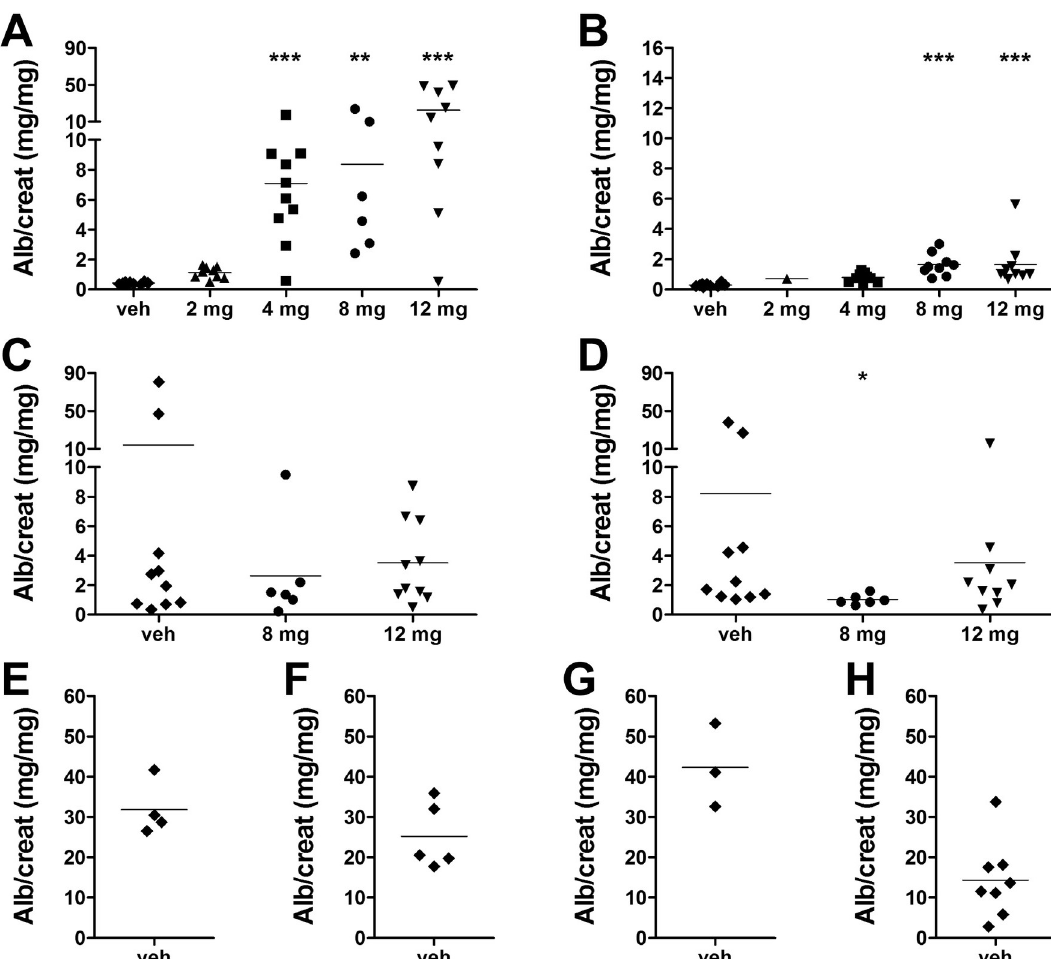
Fig 1. Different doses healthy plasma were injected in the Thy-1.1 mice with different backgrounds to determine maximum injection dose. ( A ) Balb/c Thy-1.1 males, ( B ) Balb/c Thy-1.1 females, ( C ) C57BL/6 Thy-1.1 males, ( D ) C57BL/6 Thy-1.1 females were injected intravenously with various doses healthy plasma protein at 5 weeks ± 3 days old. ( E ) 129X1/Sv Thy-1.1 males, ( F ) 129X1/Sv Thy-1.1 females, ( G ) 129S2/SvPas Thy-1.1 males, and ( H ) 129S2/SvPas Thy-1.1 females received PBS vehicle (veh) injection only. Individual animal data and group means of urinary albumin/creatinine (alb/creat, mg/mg) ratio are presented. One-way ANOVA: � p � 0.05, �� p � 0.01, ��� p � 0.001 versus vehicle.